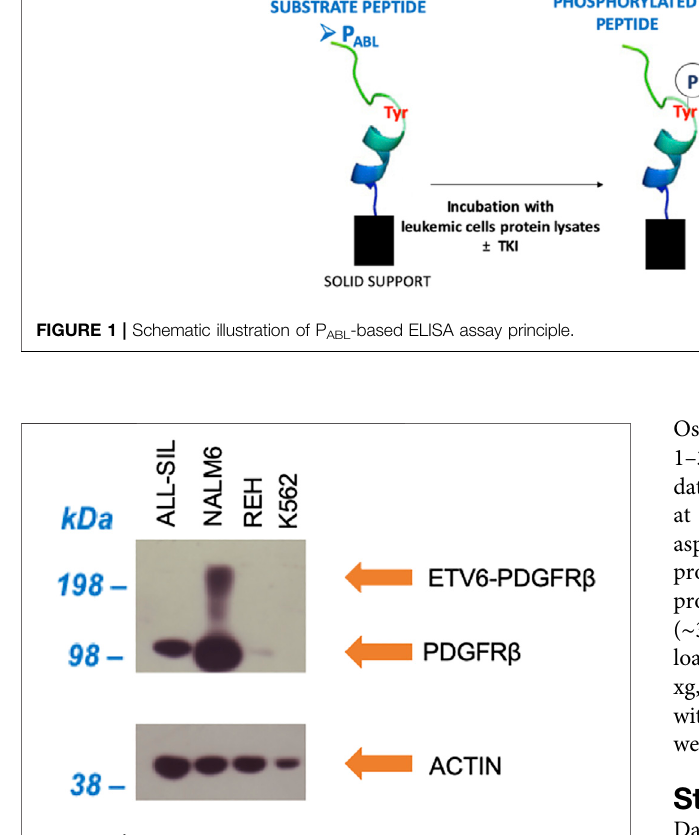
Frontiers in Pharmacology |